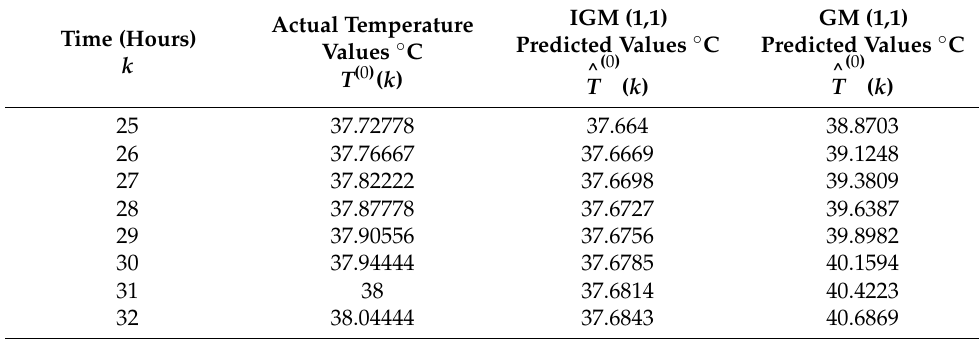
Table 1. Comparison of IGM (1,1) and GM (1,1) models’ predicted values for Oklahoma University’s GHPS output temperature for the period from 25 to 32 h